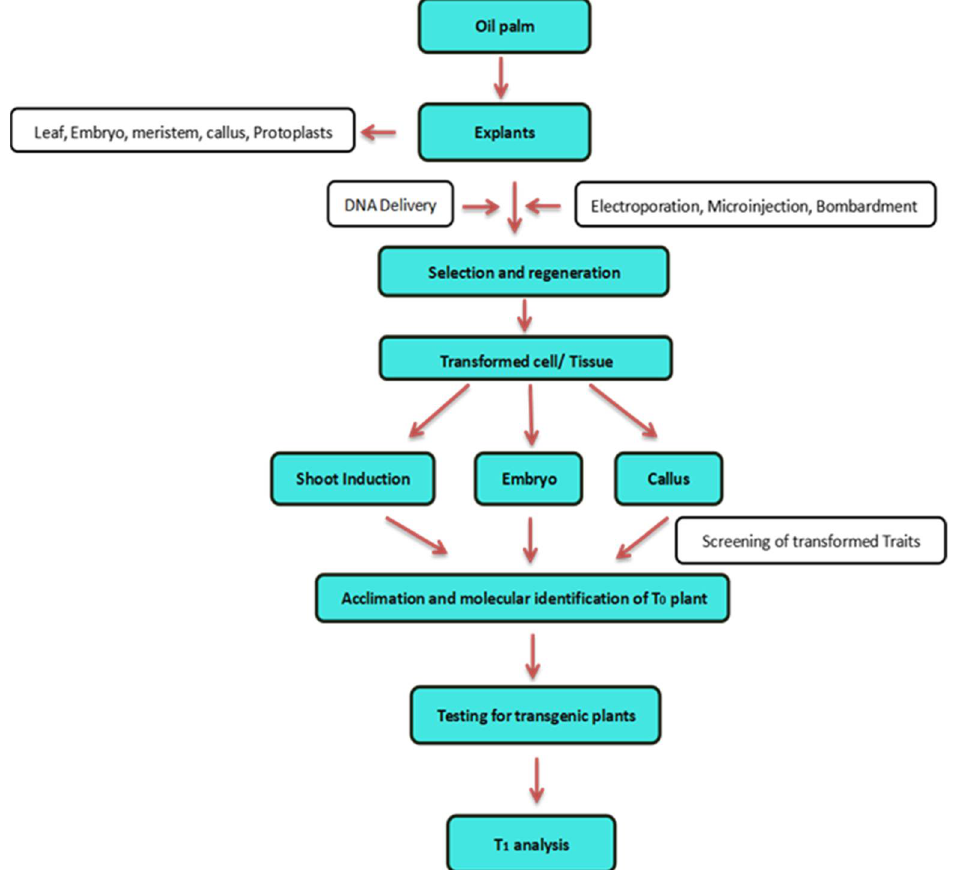
Figure 2. A summary of the technique for producing transgenic oil palm utilizing the direct DNA delivery method.